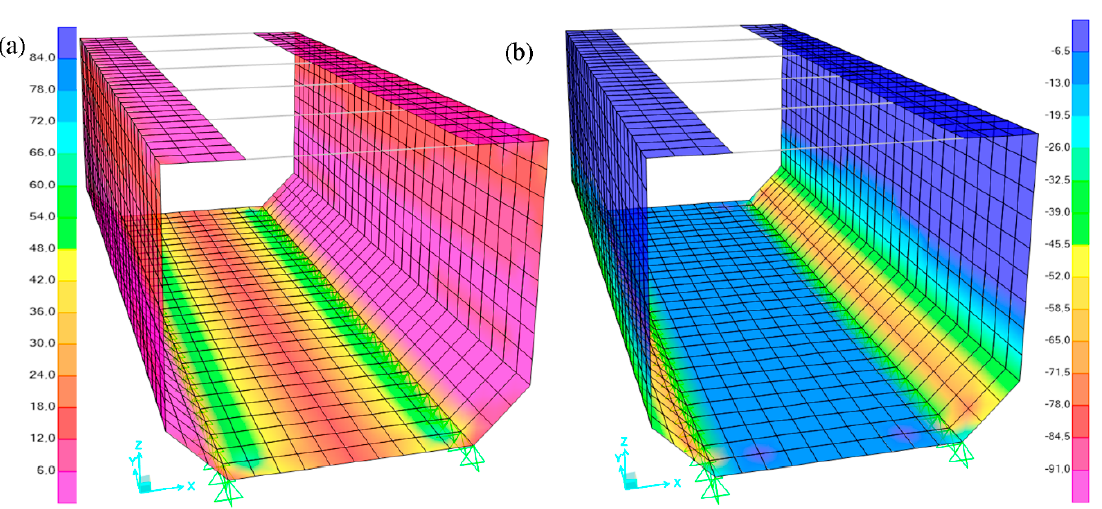
Figure 9. Shear envelopes (kN/m) in ULS for the load combination C 2 : ( a ) V dmax and ( b ) V dmin .